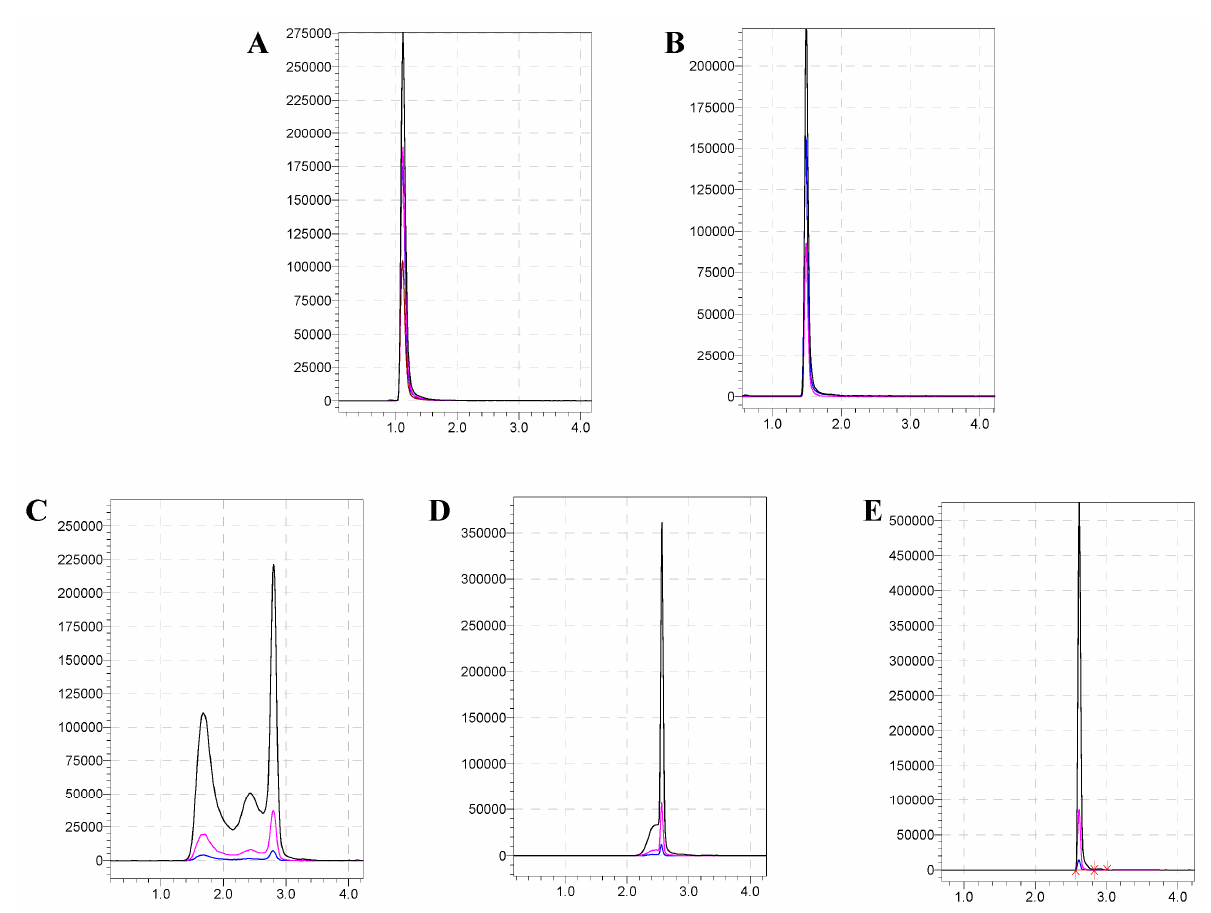
Figure 3. Effect of initial ratio of different mobile phases on chromatographic peak pattern. ( A ): C18 column; ( B ): C18-AQ column; ( C – E ): Chromatograms of HILIC columns with different initial mobile phase ratios of 75%, 83%, and 90%, respectively.